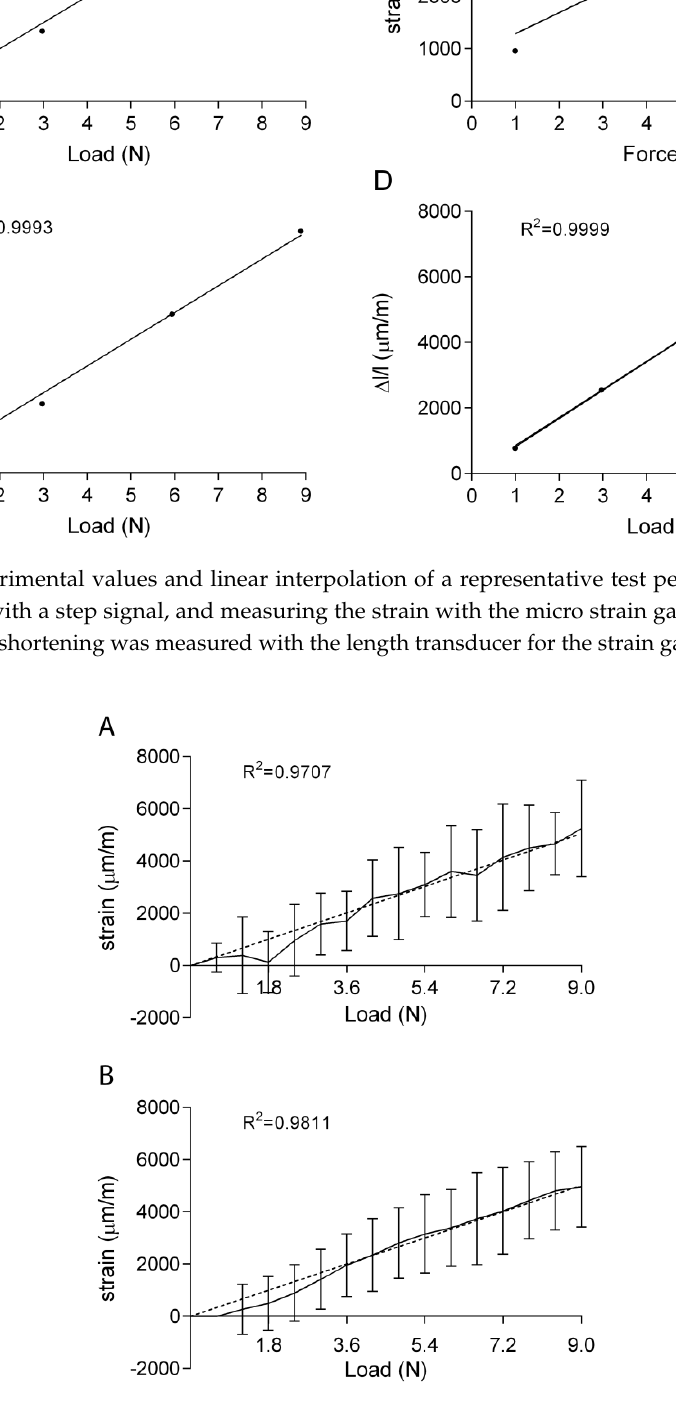
Figure 4. Means ± SDs of the values measured by DIC when loading the specimens with a 4 Hz triangular load of 9 N ( A ). A one-point moving average filter allowed the relationship to be more linear ( B ). n = 3.